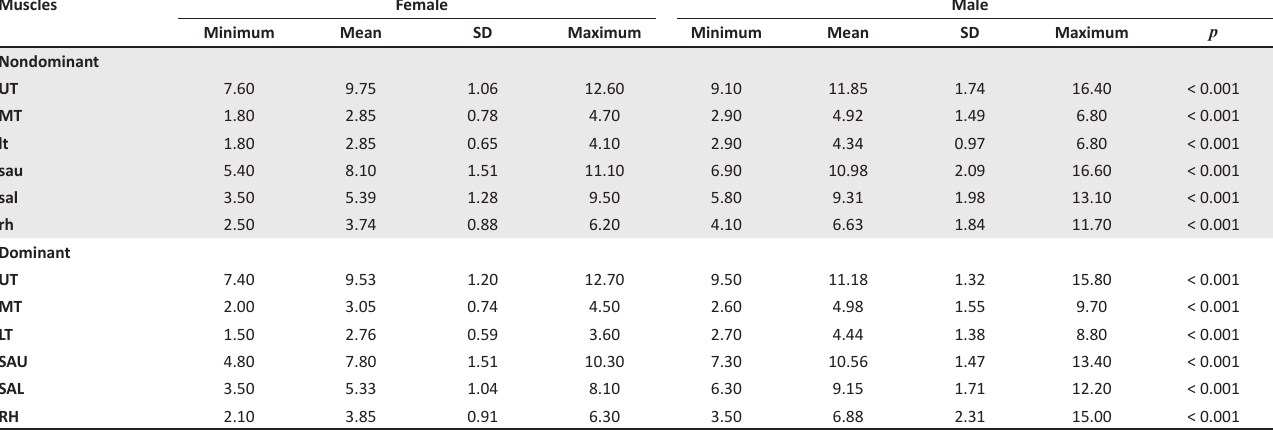
TABLE 2: A comparison between the force measurements in female ( n = 29) and male participants ( n = 29) ( n = 58) (measurements in kgf: means and SD). Muscles Female Male Minimum Mean SD Maximum Nondominant